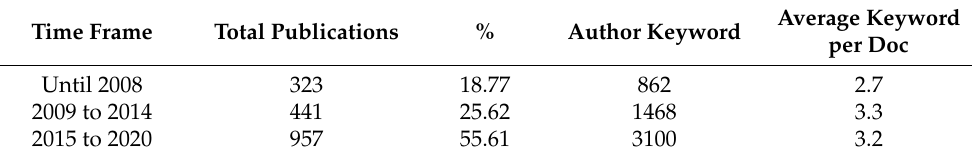
Table 1. Quantification and characterization of keywords 1990 – 2020.